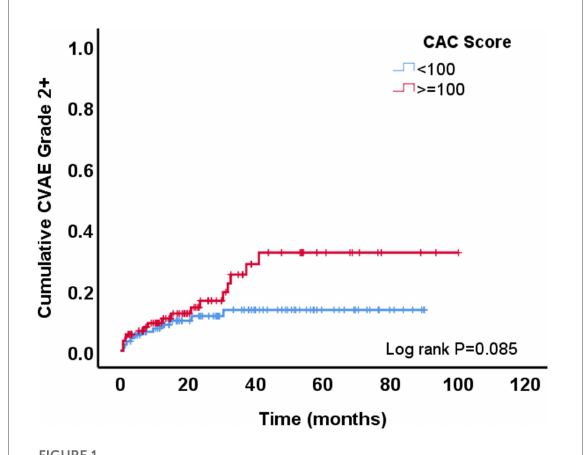
FIGURE1 Development of grade ≥ 2 cardiovascular adverse events (CVAE) overtime among patients with coronary artery calcium (CAC) score < 100 AU vs. those with a score ≥ 100 AU.